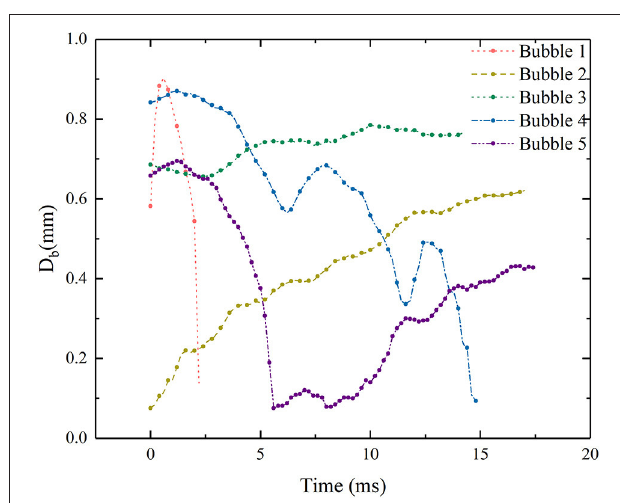
FIGURE 6 | Single sliding bubble diameter